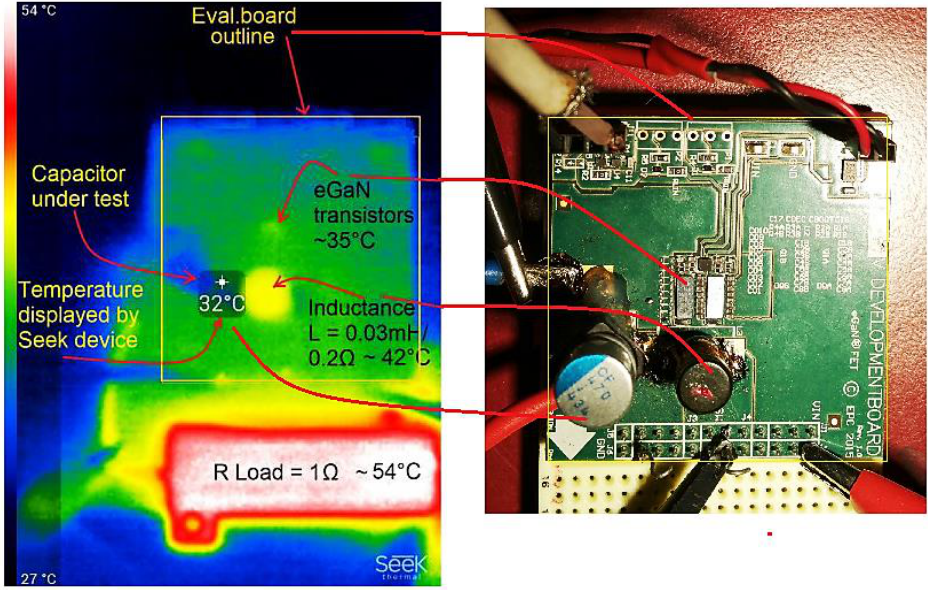
Figure 6. EPC9059/30V development board [24] containing two EPC2100 eGaN transistors [25] ( right ) and thermal photo of it showing capacitor’s temperature ( left ).